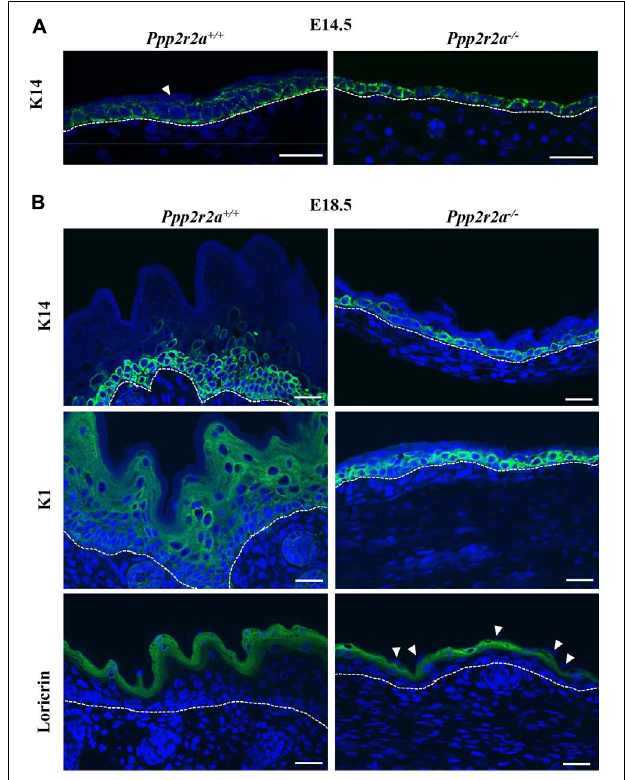
FIGURE 5 | Epidermal defects are associated with abnormal differentiation. Immunofluorescent labeling for epidermal markers Keratin 14 (K14), Keratin 1 (K1) and Loricrin (green) in E14.5 (A) and E18.5 (B) embryos, with nuclei stained by DAPI (blue). White arrowheads show the unstained superficial epidermal cell layer. Dashed white line indicates the dermal-epidermal junction. All scale bars = 25 µ m.